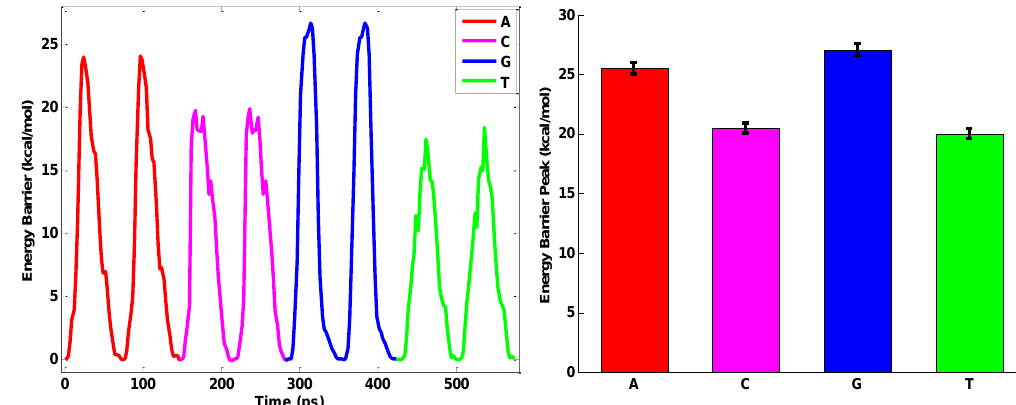
Figure 7. Energy profile when ssDNA passed through the circular hBN nanopores. The energy peak values for different nucleotides are extracted from the energy profile.